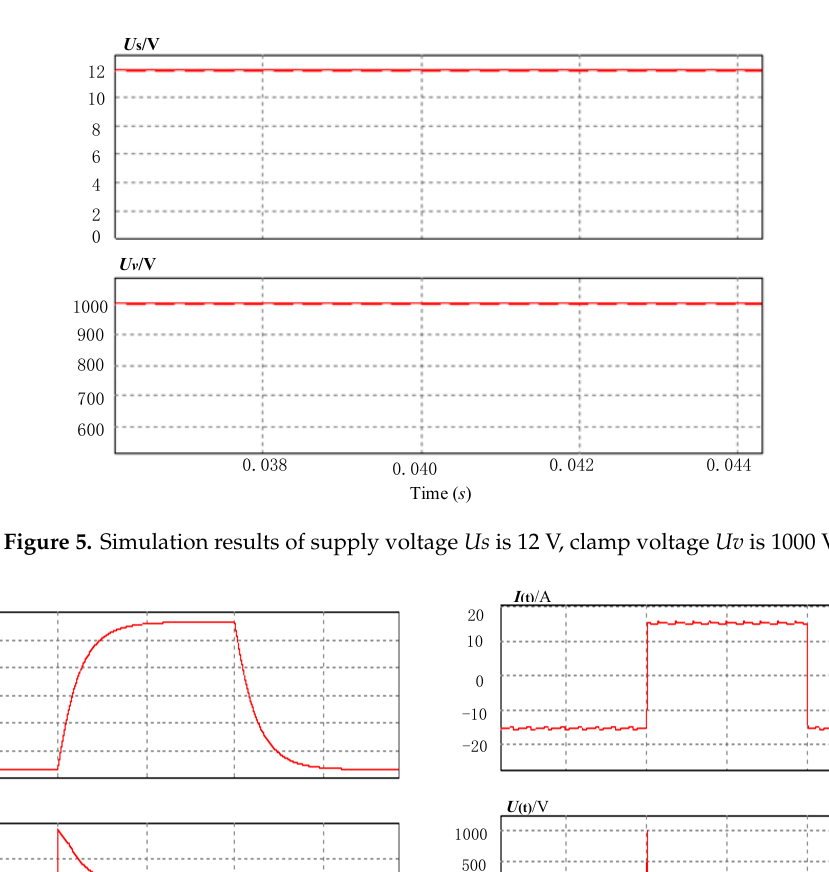
Figure 7. Waveforms of the output current and voltage, 1 KHz. ( a ) Traditional full-bridge circuit; ( b ) Constant current and voltage clamping control circuit.